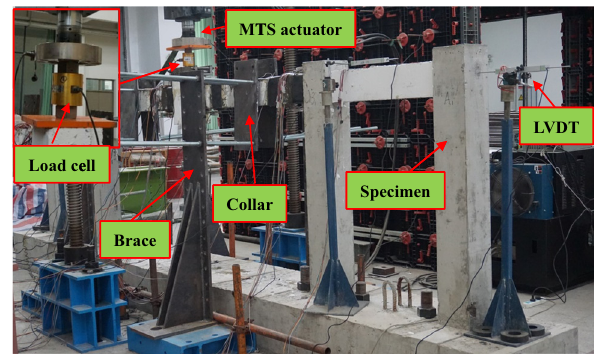
Figure 4: Typical test setup.